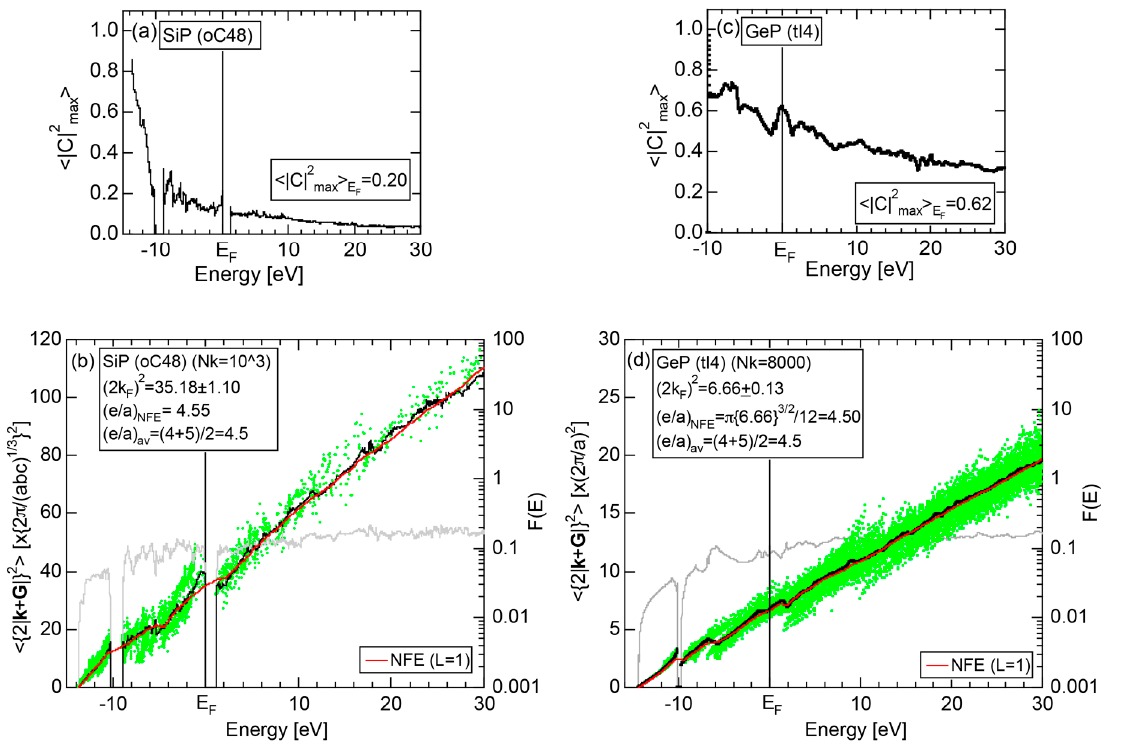
max2 (cid:69) (cid:68) and ( b ) Hume-Rothery plot for SiP (oC48). The corresponding data for GeP Figure 68. ( a ) C | C | 2 Figure 68. ( a ) and ( b ) Hume-Rothery plot for SiP (oC48). The corresponding data for GeP E max E (tI4) are in ( c , d ). See captions of Figure 19 (b) for symbols in (b) and (tI4) are in ( c , d ). See captions of Figure 19 (b) for symbols in (b) and (d).